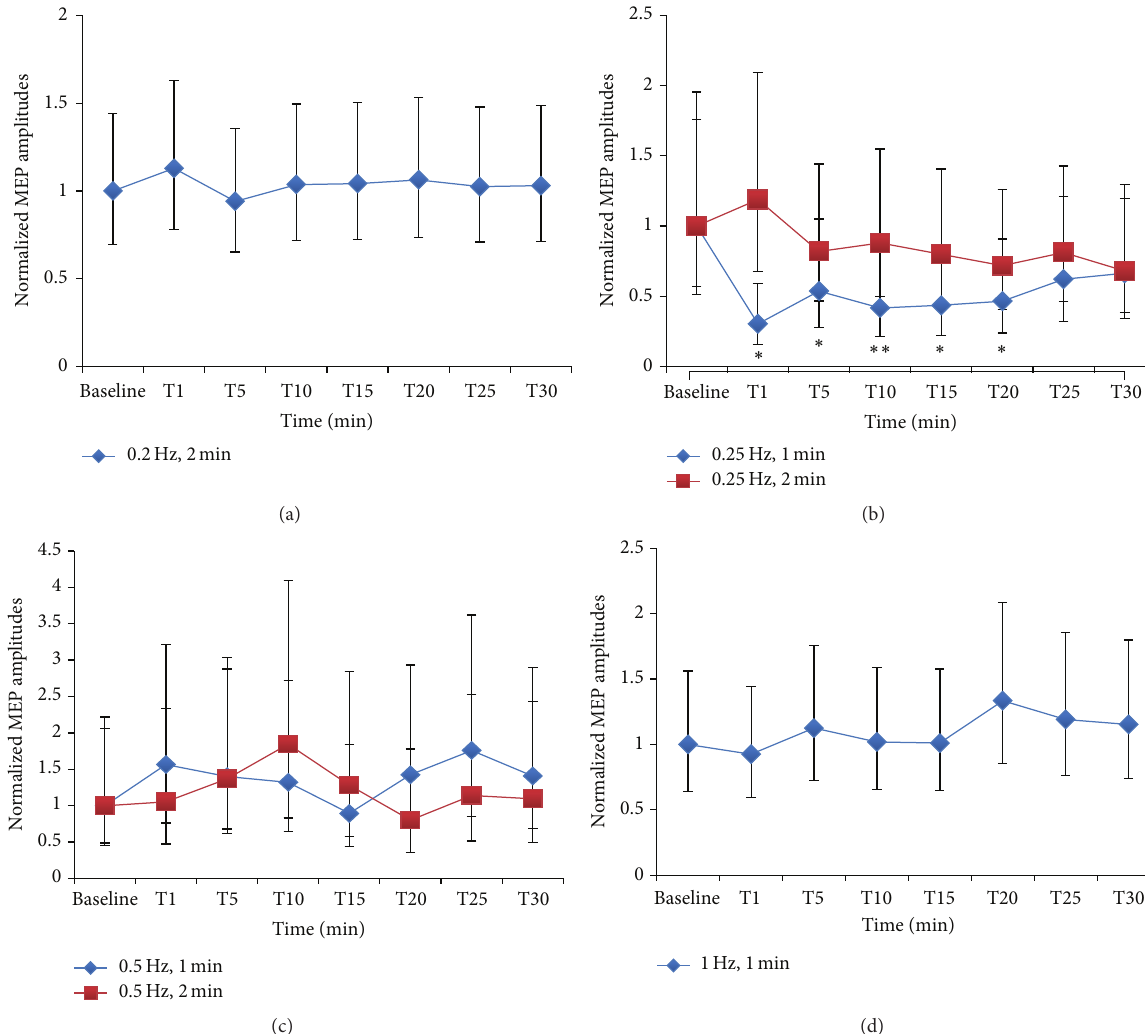
Figure 2: Normalized MEP amplitudes of 6 subjects with 95% confidence interval of each PAS 10 ms protocol. One-way repeated-measures ANOVA showed a statistically significant inhibition, an LTD-like effect, of PAS 10 ms protocol of 1-minute stimulation of 0.25 Hz (reporting as an uncorrected 𝑝 value) ((b); diamond shape; ∗∗ 𝑝 value < 0.05). Post hoc analysis of this protocol showed that the inhibitory effect (reporting as an uncorrected 𝑝 value) began immediately after applying PAS 10 ms (T1), 10 (T10), 15 (T15), and 20 minutes (T20) ( ∗ 𝑝 value < 0.05). The maximum inhibition was approximately 70% reduction. The PAS 10 ms protocols of 2-minute stimulation of 0.2 Hz (a), 0.25 Hz ((b) square shape), and 0.5 Hz ((c) square shape) and 1-minute stimulation of 0.5 Hz ((c) diamond shape) and 1Hz (d) did not show either inhibition or facilitation. Min = minute, MEP = motor-evoked potentials, LTD = long-term depression, and PAS 10 ms = paired associative stimulation with interstimulus interval of